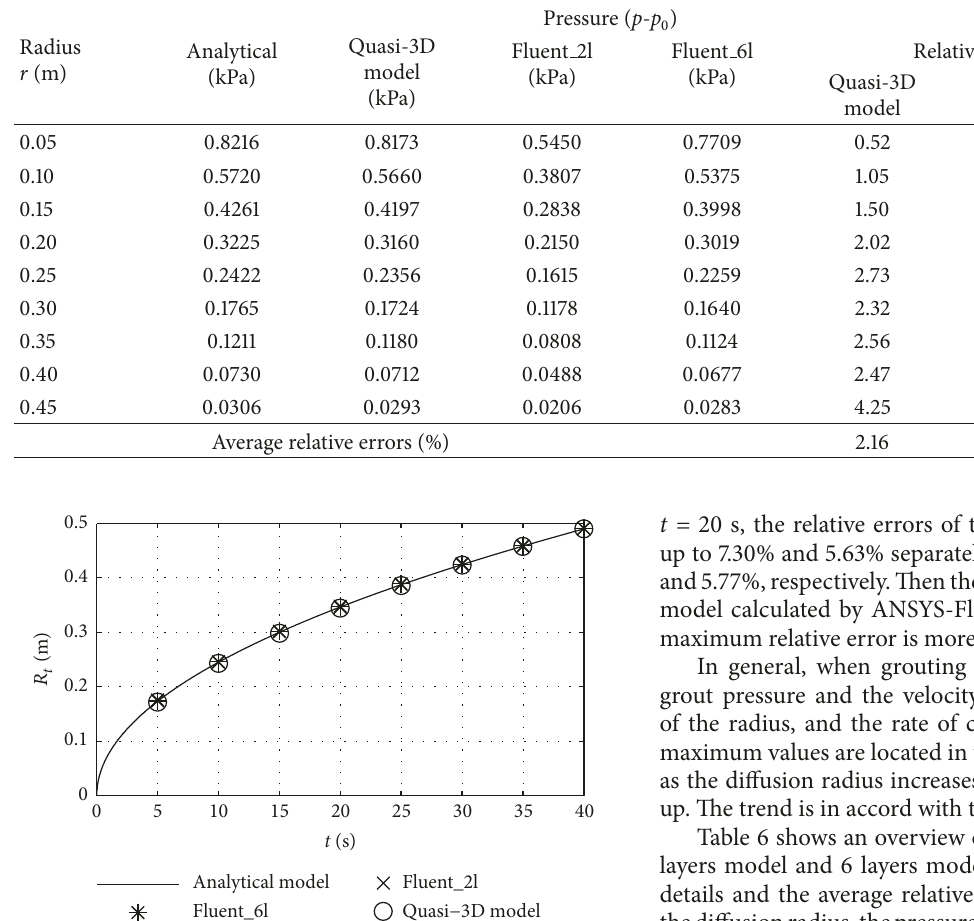
Table 3: Grout pressure distribution over radius at t = 40 s in Case 1.